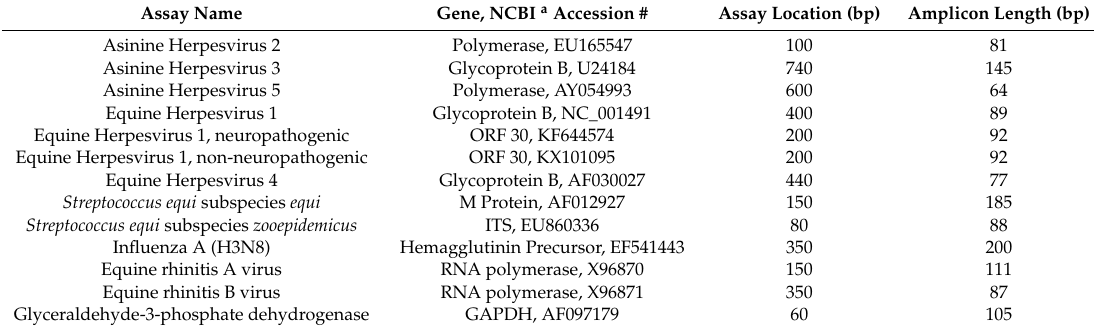
Table 1. Target genes used for qPCR-assay pathogen loads